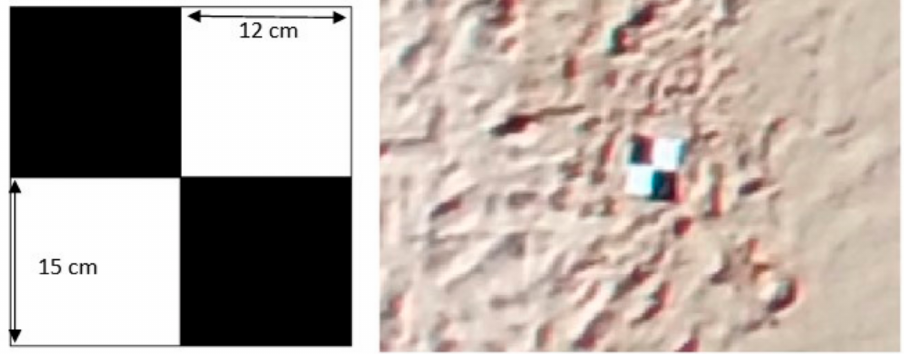
Figure 4. Dimensions of the GCP used and an aerial view of one of them already placed on the